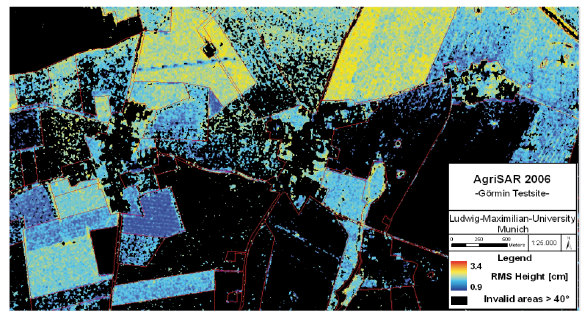
Figure 8. Spatial distribution of s . Invalid areas with polarimetric alpha angle α > 40° are masked out black